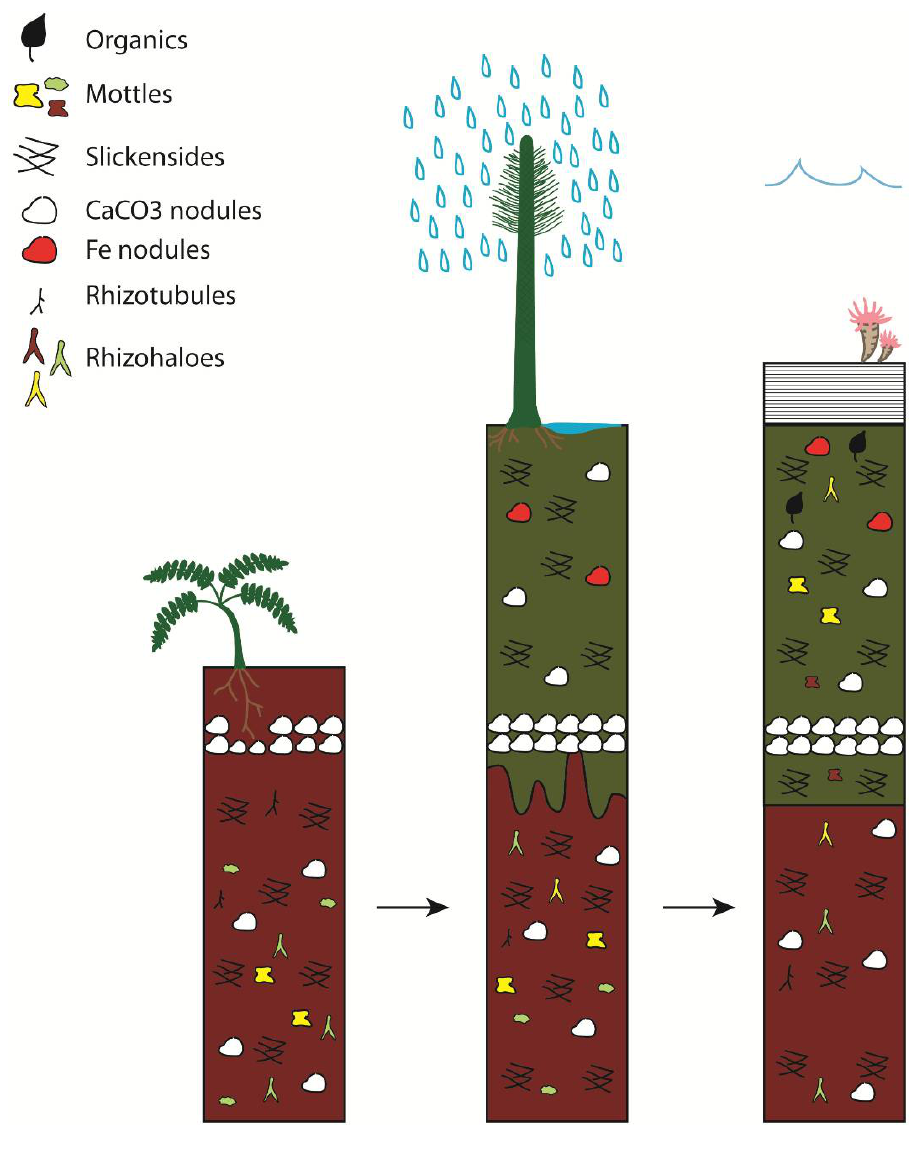
Figure 8. Stratigraphic columns showing the effects of the changing climate on formation of Paleosols 1 and 2. ( a ) Vertisol (Paleosol 1) formation occurring in a seasonally dry climate; ( b ) Increased precipitation leads to gleization of the underlying Vertisol and the formation of a gleyed Inceptisol (Paleosol 2); ( c ) Sea level rise results in cessation of soil formation